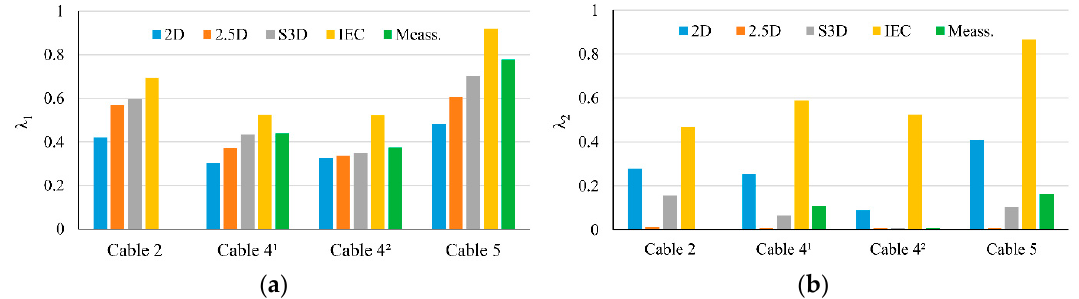
Figure 13. Loss factor obtained from FEM models, IEC standard and experimental measurements (solid bonding) for: ( a ) the screens; ( b ) the armor.